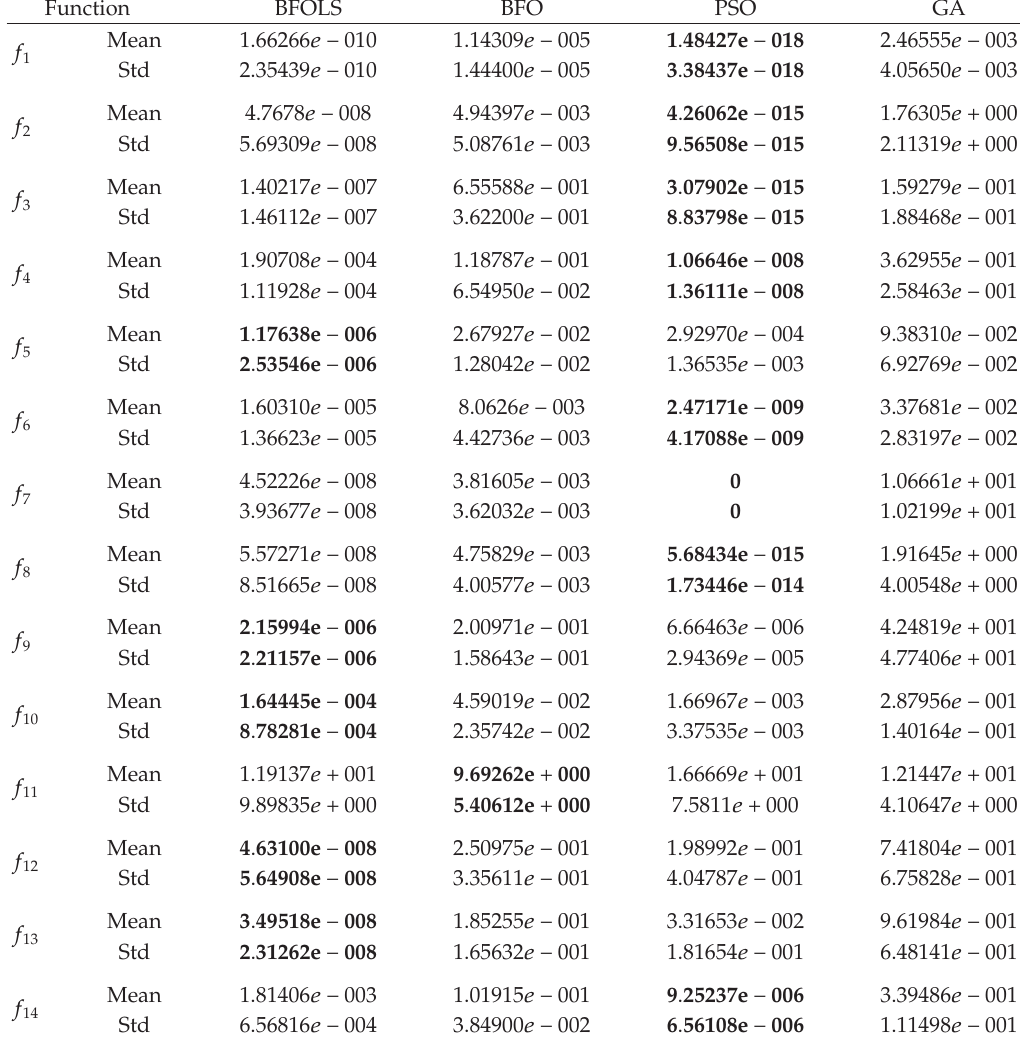
Table 2: Error values obtained by BFOLS, BFO, PSO, and GA algorithms with dimension of 2. Function BFOLS BFO PSO